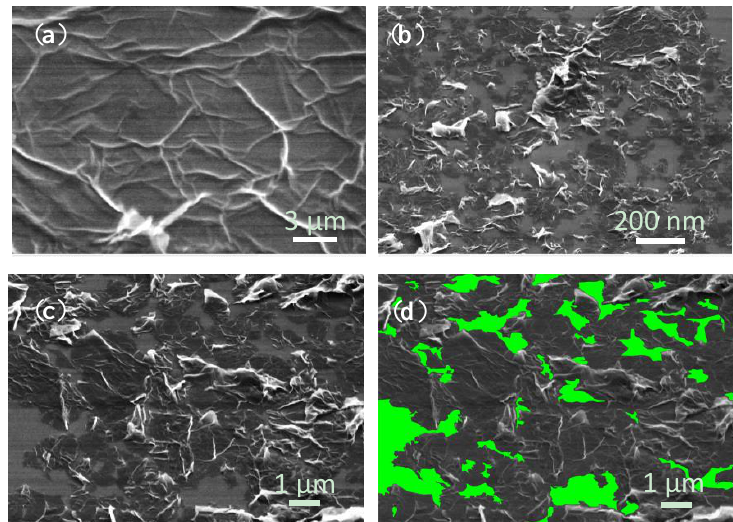
Figure 2. ( a ) SEM image of MGFs deposited on a silicon wafer; ( b ) high magnification SEM image of a graphene flake deposited on silicon; ( c ) SEM image for the calculation of the areal coverage; and ( d ) the corresponding processed image with the blank areas marked in green.